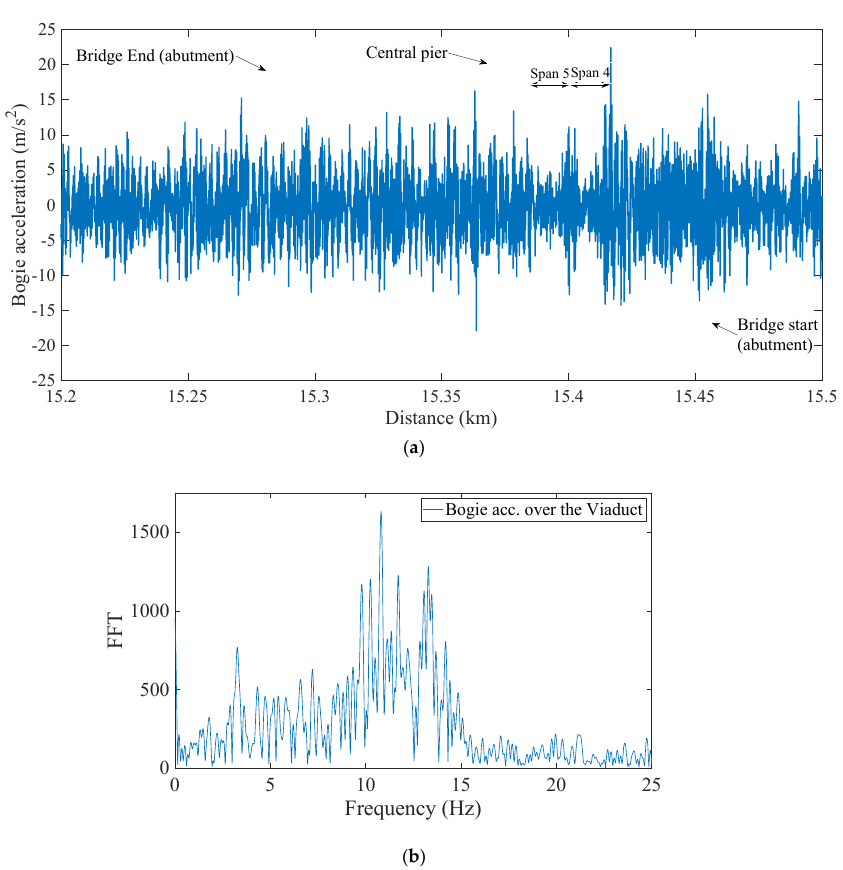
Figure 7. Bogie vertical acceleration in: ( a ) time domain, and ( b ) frequency domain (on − bridge data).